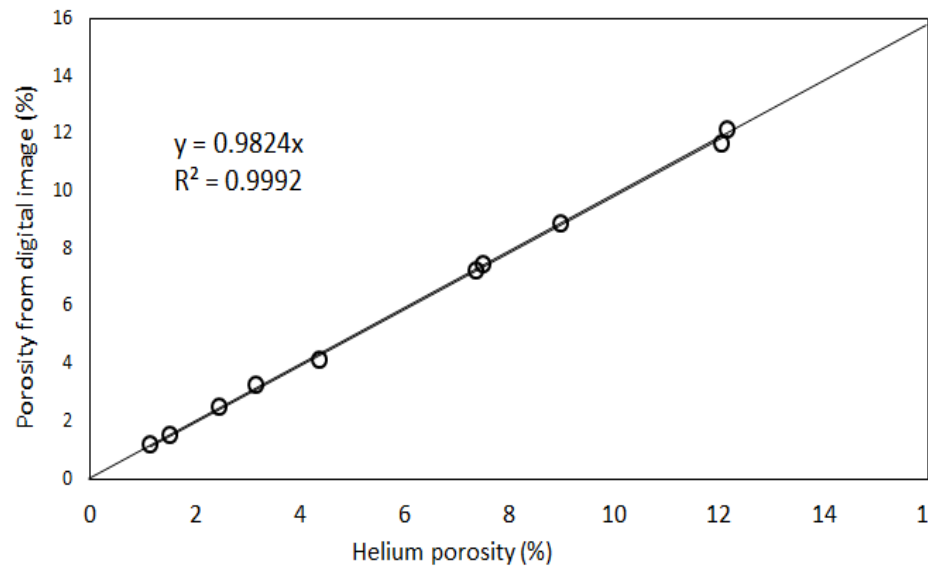
Figure 18. Porosity computed from digital image versus measured